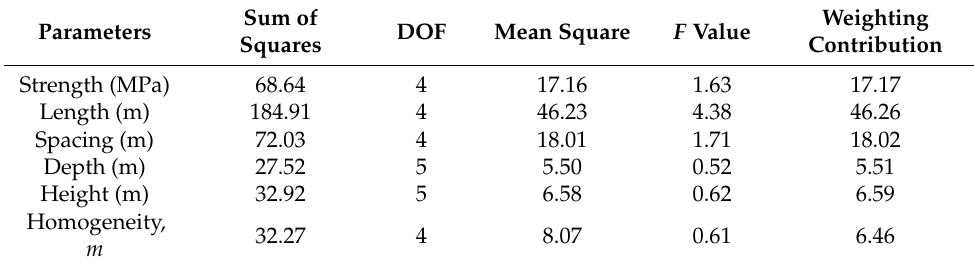
Table 2. Summary of ANOVA for shear